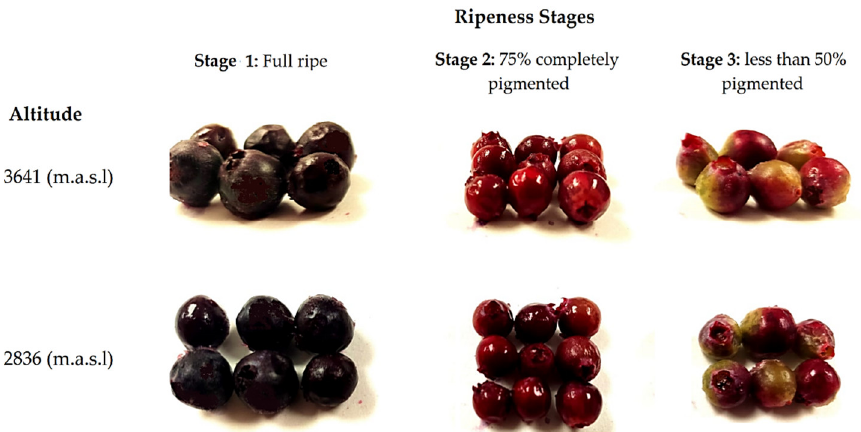
Figure 1. Wild Andean blueberries ( V. floribundum Kunth) collected at three stages of ripeness based on their pigmentation at two different altitudes.